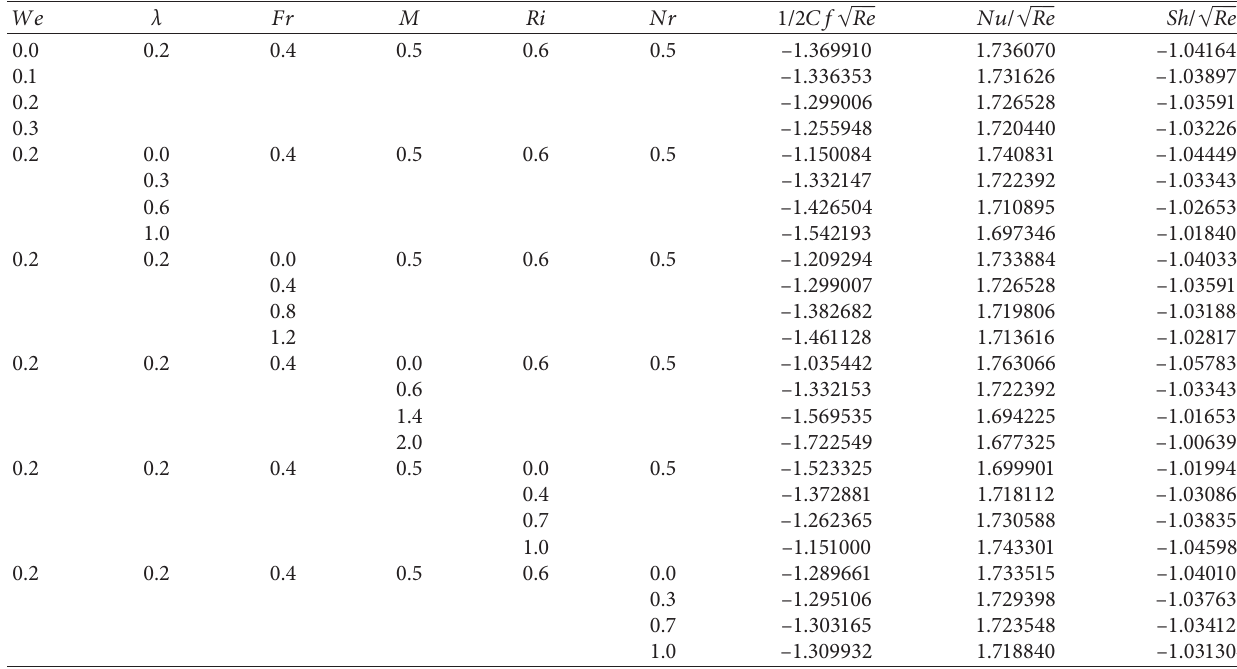
Table 2: Numerically obtained values of skin friction coefficient, local Nusselt number, and local Sherwood number for various values of We, λ , Fr, M, Ri, and Nr